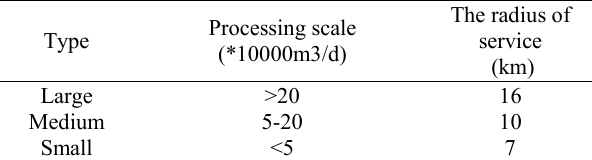
Table 5. Size of wastewater treatment plants.